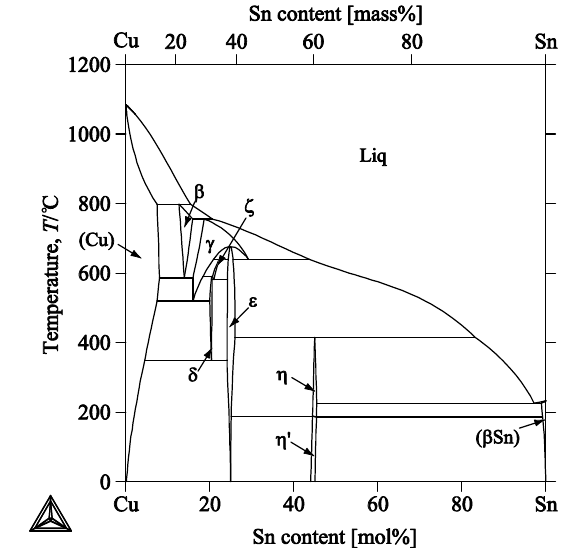
Figure 6. Calculated binary phase diagram of the Sn-P sys- tem.